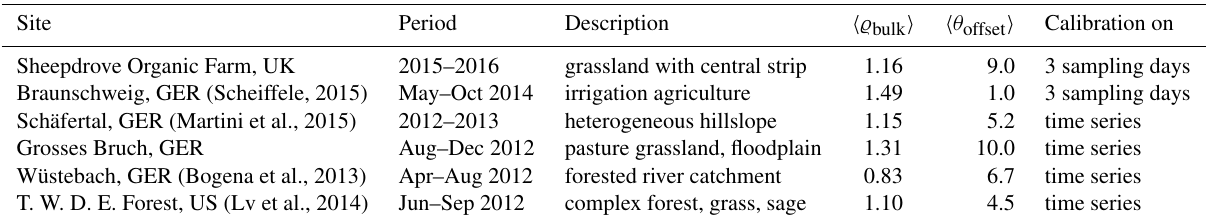
Table 1. Overview of the investigated study sites, their average bulk densities (cid:104) (cid:37) bulk (cid:105) (in gcm − 3 ), and average volumetric water equiva- lent (cid:104) θ offset (cid:105) of additional hydrogen pools (e.g., soil organic carbon, lattice water, root biomass; see Eq. 2). Site Period Description (cid:104) (cid:37) bulk (cid:105) (cid:104) θ offset (cid:105) Calibration on Sheepdrove Organic Farm, UK 2015–2016 grassland with central strip 1.16 9.0 3 sampling days Braunschweig, GER (Scheiffele, 2015) May–Oct 2014 irrigation